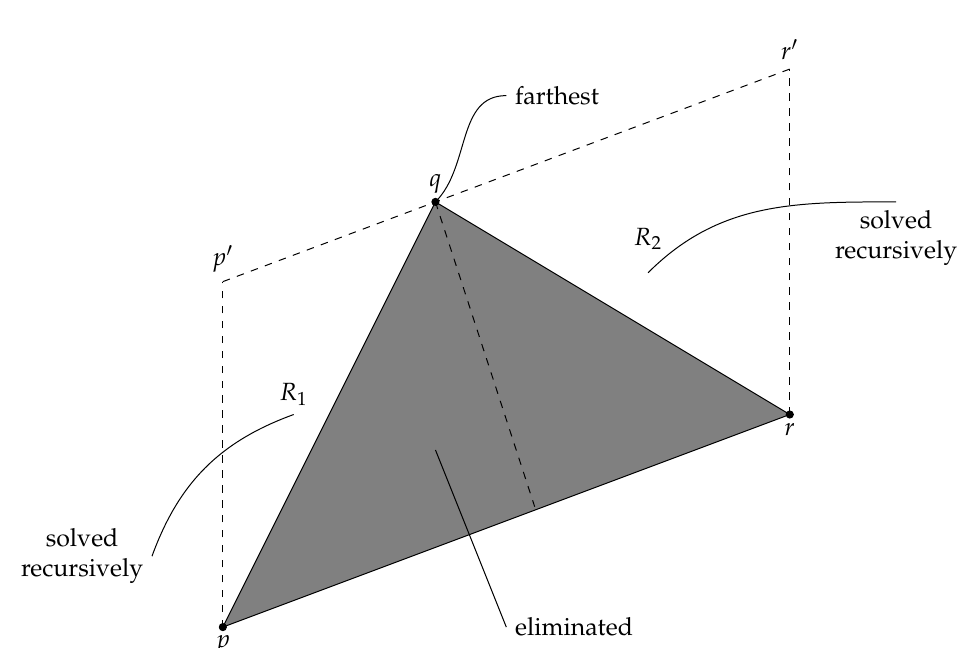
Figure 4. A visualization of the general recursive step in QUICKHULL